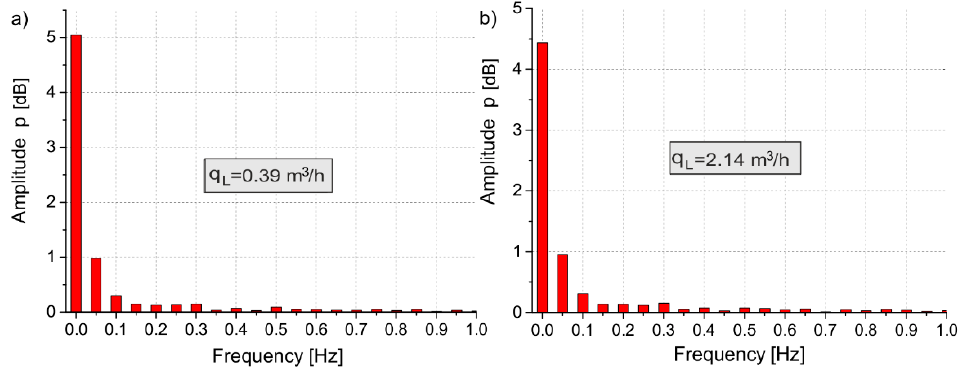
Figure 9. Spectral characteristics of the pressure signals: ( a ) d = 0.3 mm, ( b ) d = 0.7